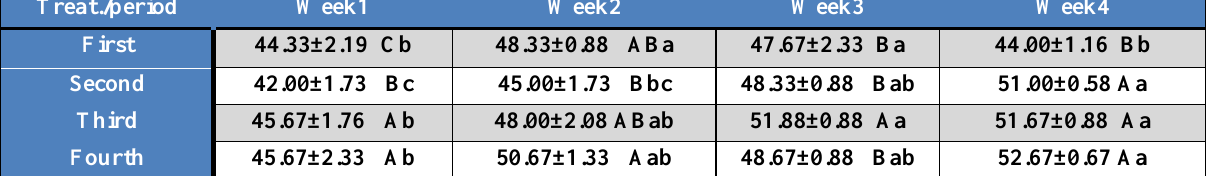
Table , 5: Effect of Vit. C and/or Vit. B on the lymphocyte percentage % of rabbits (Mean ± SE). Treat./period